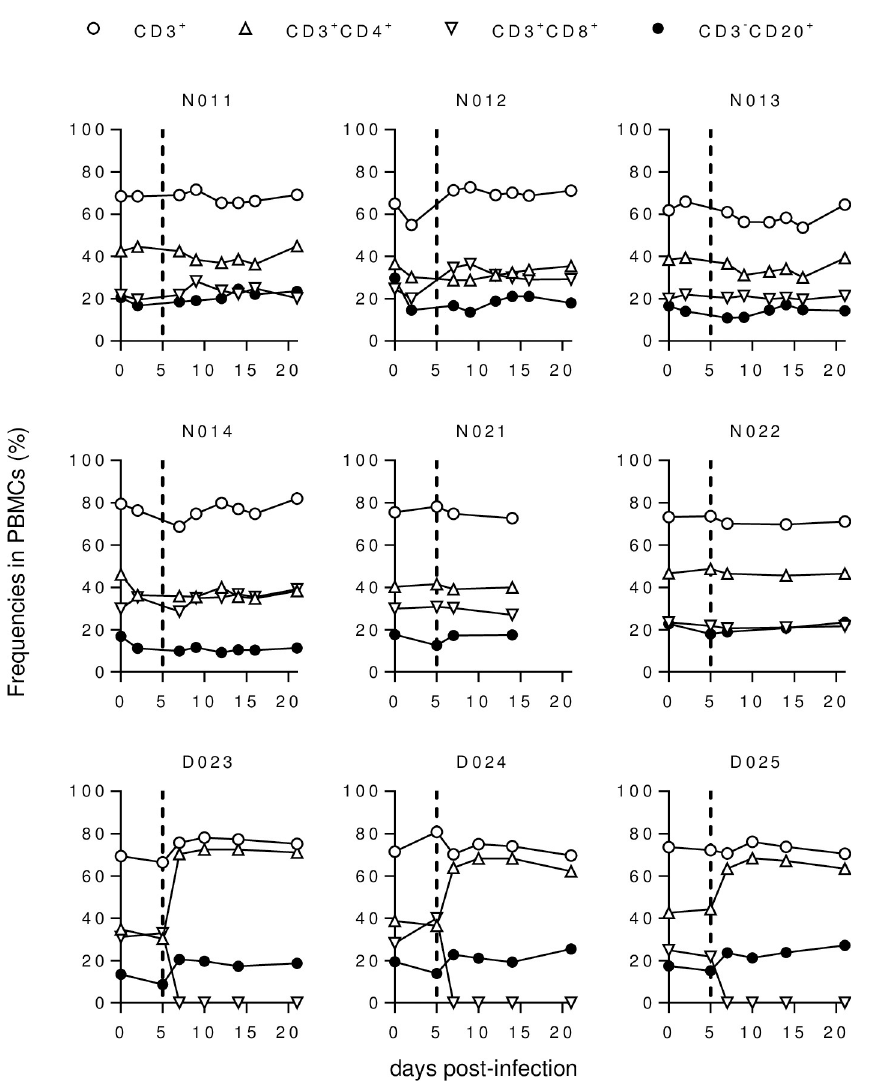
CD3 - CD20 + T cells in macaque PBMCs after SARS-CoV-2